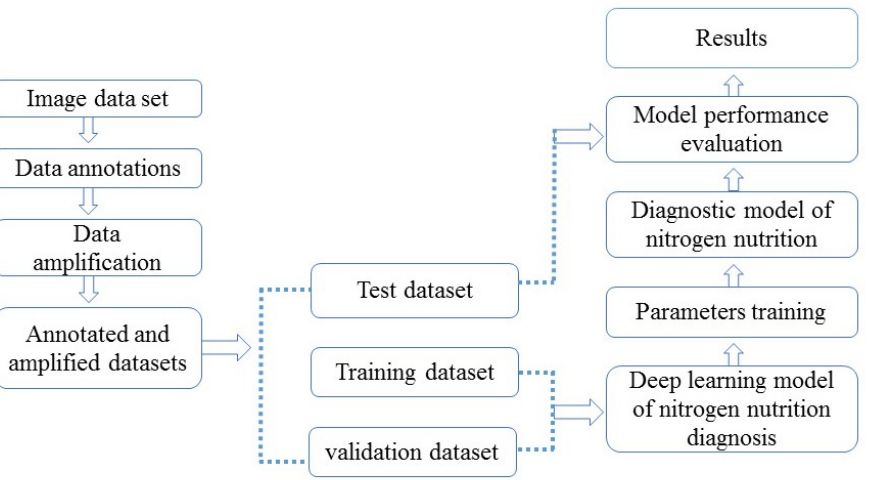
Figure 1. Systematic overview based on the deep learning approaches for the prediction of nitrogen nutrition diagnosis. The proposed system consists of several steps to collect the dataset and provides classification and prediction of results.